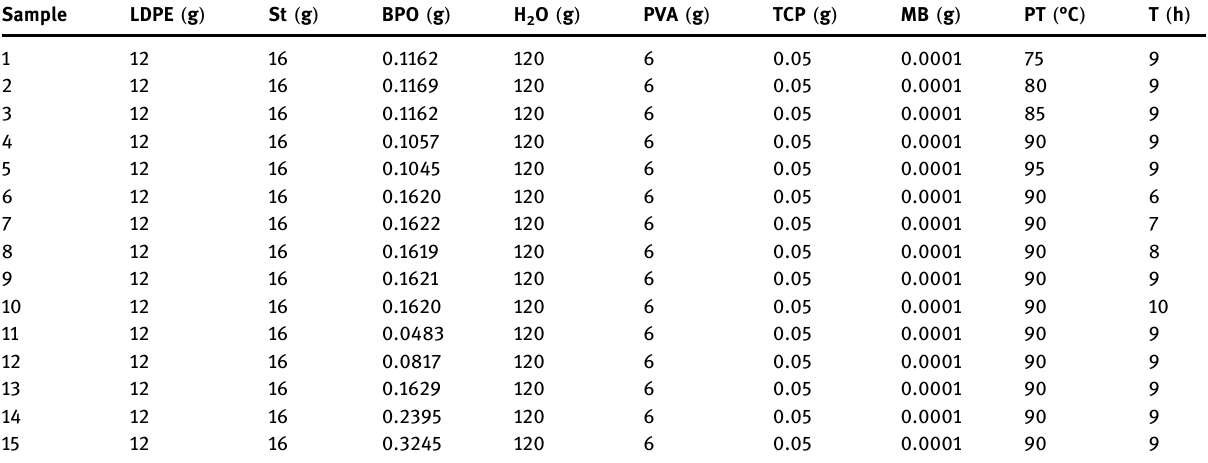
Table 1: Preparation ingredients of LDPE/PS interpolymer resin particles